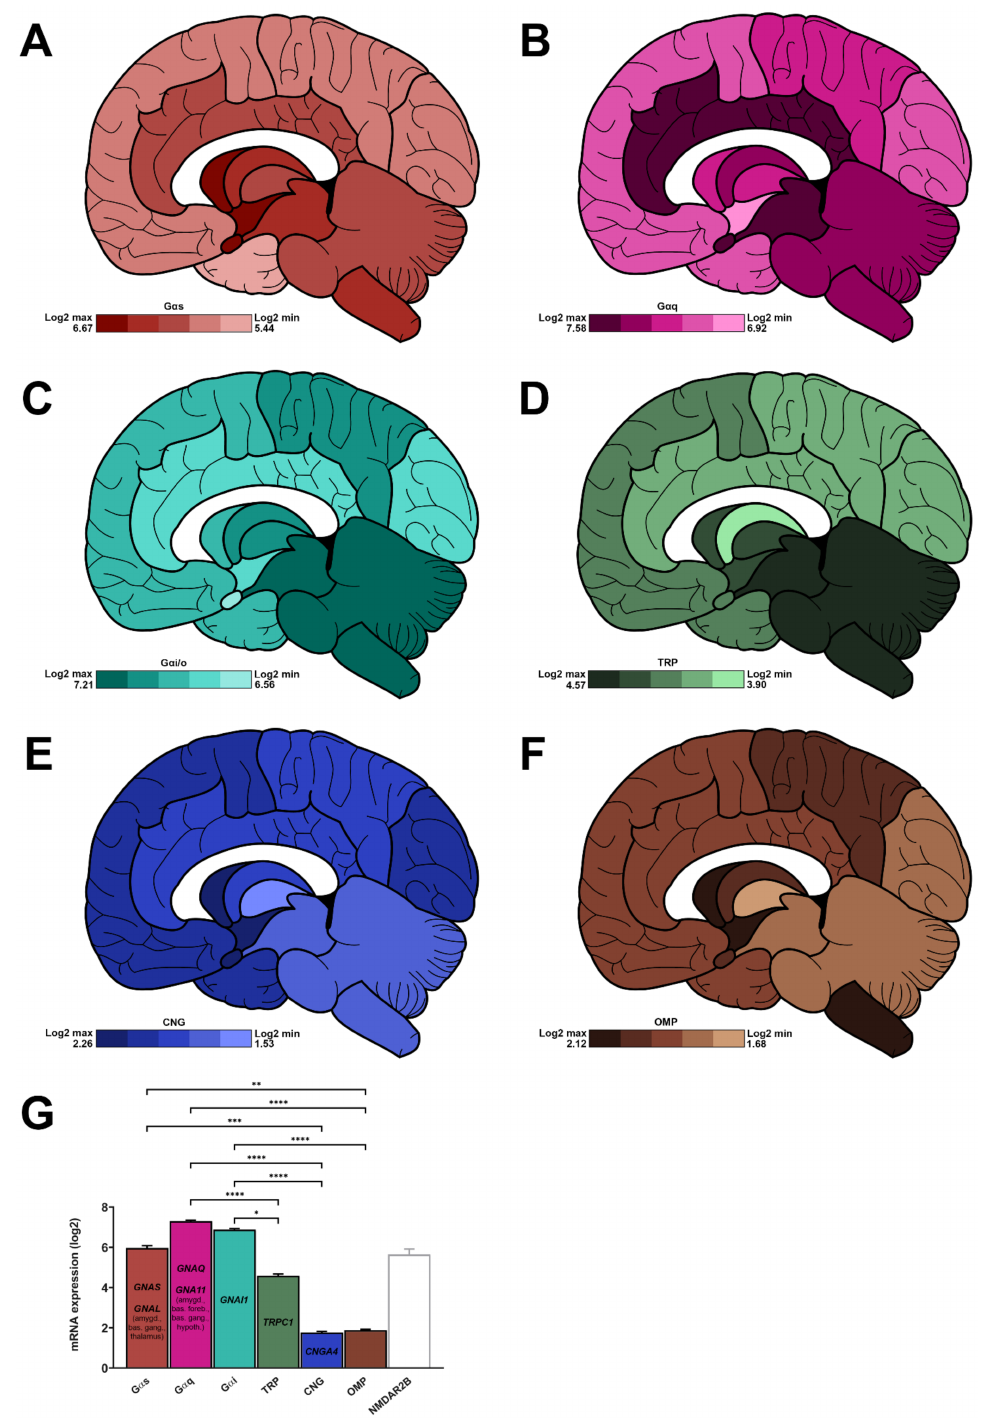
Figure 5. Regionalised mean expression of chemoreceptor-associated partners in a human brain collected from a 31-year-old Caucasian subject. ( A – F ), log2 expression for G α s ( A , red), G α q ( B , pink), G α i/o ( C , light blue), transient receptor potential channels ( D , green), cyclic nucleotide-gated channels ( E , dark blue), and olfactory marker protein ( F , brown). The maximum and minimum expression levels are indicated in the bottom left panel for each family. ( G ) mean expression for each family in the whole brain ( n = 13 main areas). The most expressed members for each family is indicated inside each bar. NMDAR2B gene expression (empty bar, grey, was added as a positive control). *: p < 0.05, **: p < 0.01, ***: p < 0.001, ****: p < 0.0001 (Kruskal–Wallis test followed by Dunn’s multiple comparisons post hoc test). For clarity purposes, NMDAR2B was excluded from the statistical